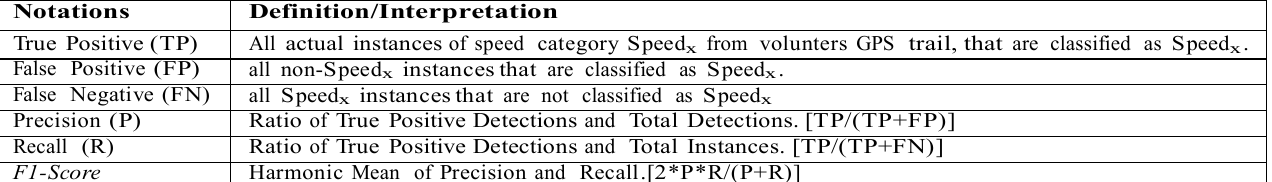
Table 7. Significance of True Positive, False Positive, False Negative and F1-Score.